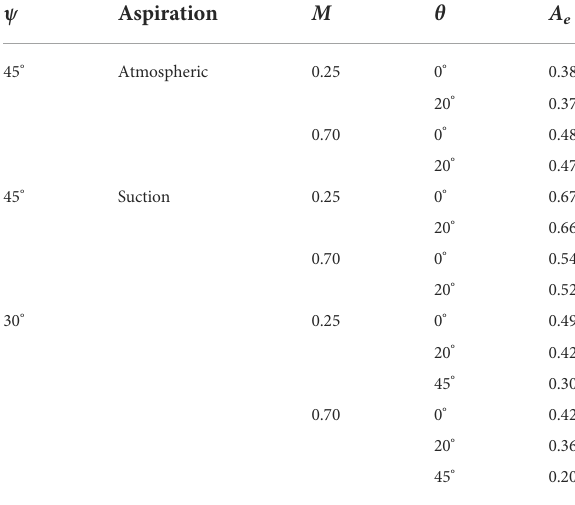
TABLE 1 Aerodynamic study aspiration ratio